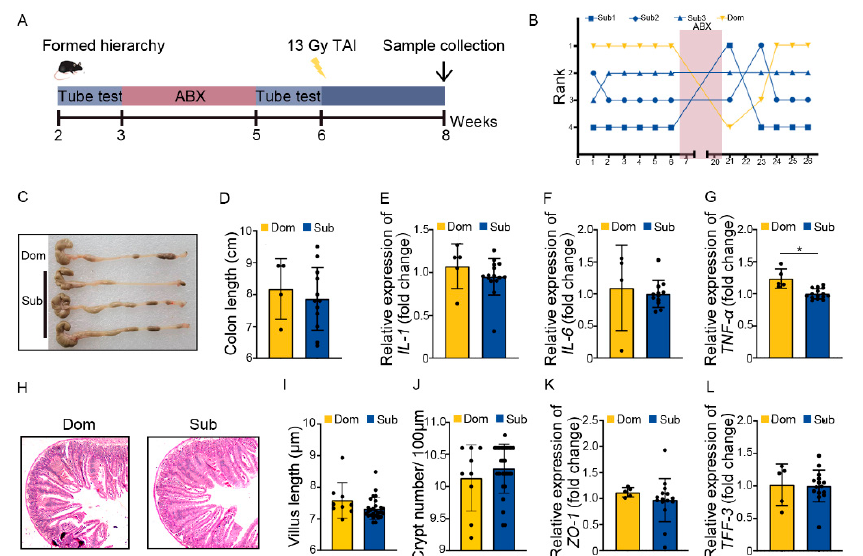
Figure 3. ABX treatment eliminated the difference in intestinal radiation injury between Dom and Sub mice. ( A ) Experimental protocol. ( B ) The ranked positions of one cage of mice tested daily before and after ABX treatment. ( C ) Photographs of dissected colons from mice in the two groups. ( D ) Statistical results of colon length between the two groups. ( E – G ) The mRNA levels of IL − 1 , IL − 6 , and TNF −α in small intestinal tissues of mice were examined by qRT − PCR. ( H ) The morphology of small intestine was revealed by H&E staining. ( I ) Length of small intestinal villi in Dom and Sub mice. ( J ) Numbers of small intestinal crypts in Dom and Sub mice. ( K , L ) The mRNA expression levels of ZO − 1 and TFF − 3 in small intestinal tissues of mice were examined by qRT − PCR. Statistically significant differences are indicated: Student’s t test, n = 4 in Dom group, n = 12 in Sub group, * p < 0.05.